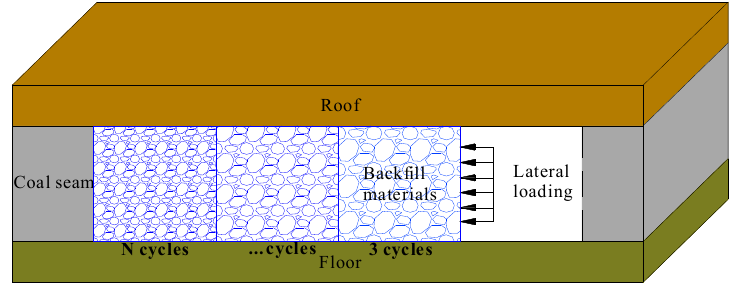
Figure 1. Schematic diagram of lateral loading on CWRs.